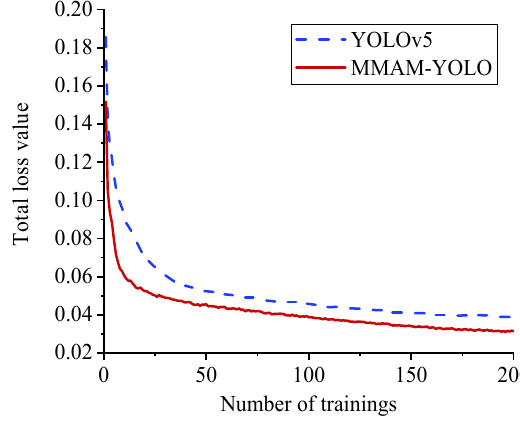
Figure 8. Total loss convergence curve.